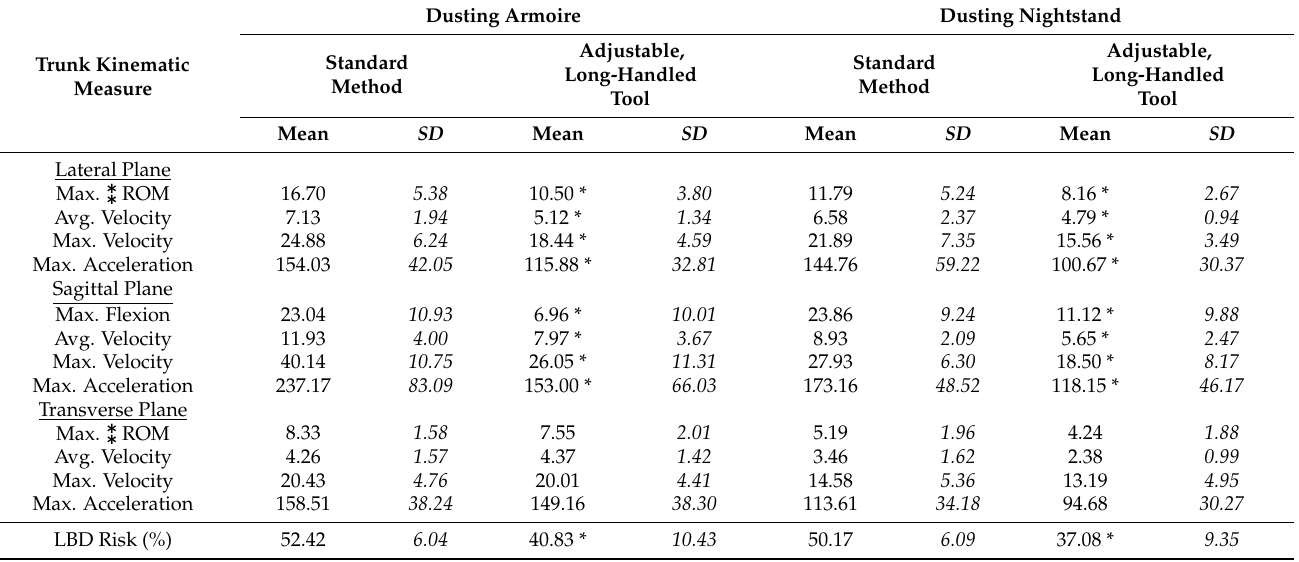
Table 1. Means and standard deviations (SD) for trunk kinematic and LBD Risk measures, for two hotel guest room dusting tasks. Range of motion values are in degrees, velocities are in deg/s, and accelerations in deg/s 2 .